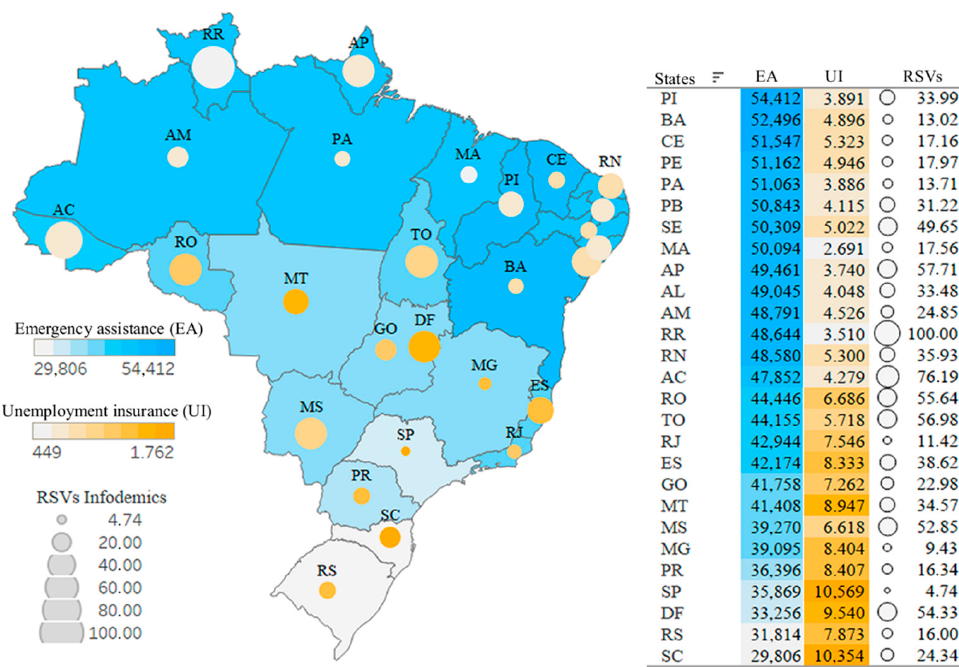
Figure 4. Spatial distribution: Infodemic RSVs and Government Programs.